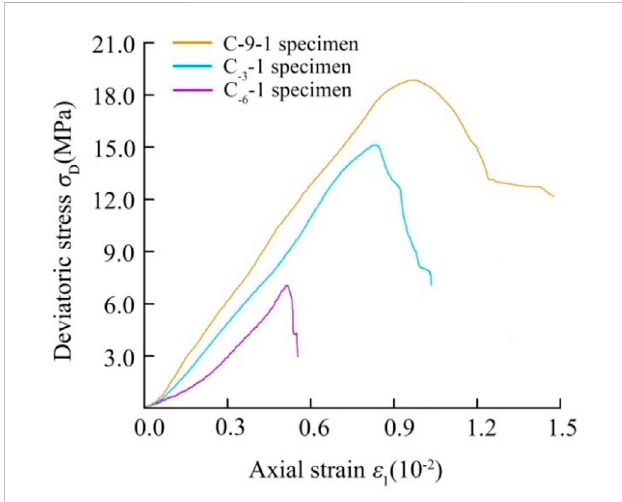
FIGURE 5 The σ D - ε 1 curves of coal specimens under the different unloading conditions.